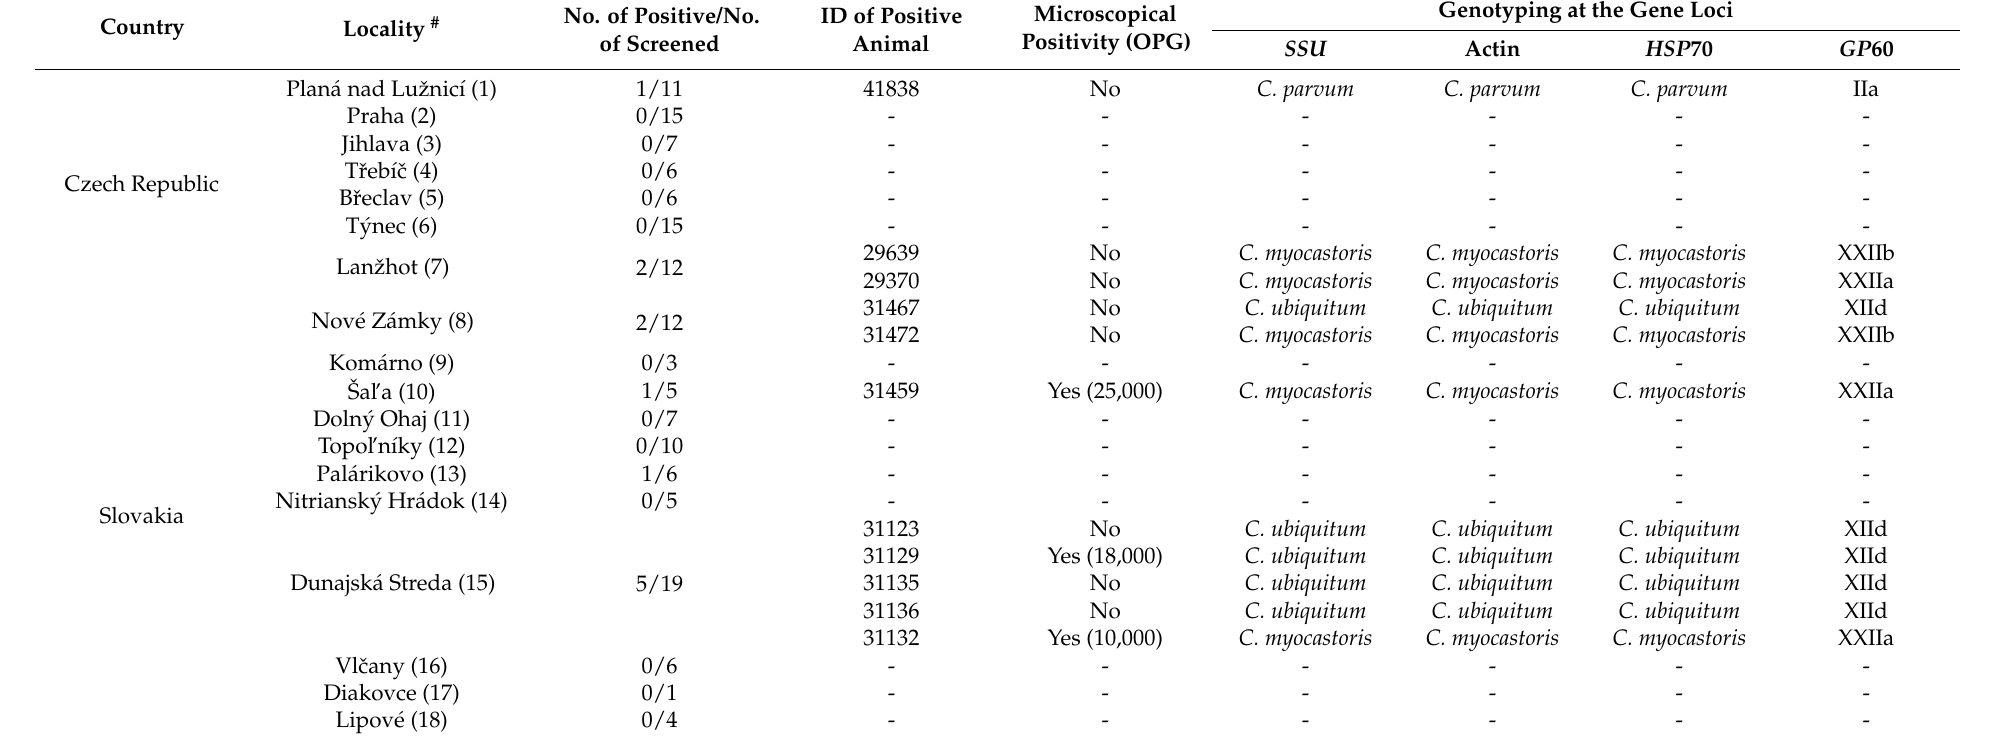
Table 1. The occurrence and genetic diversity of Cryptosporidium spp. in the present study detected by the amplification of small subunit ribosomal rRNA ( SSU ), actin, 70 kDa heat-shock protein ( HSP70 ) and 60 kDa glycoprotein ( gp60 ) gene fragments in the wild coypus ( Myocastor coypus ) in the Czech Republic and Slovakia. Oocysts were quantified by microscopy and reported per gram of faeces